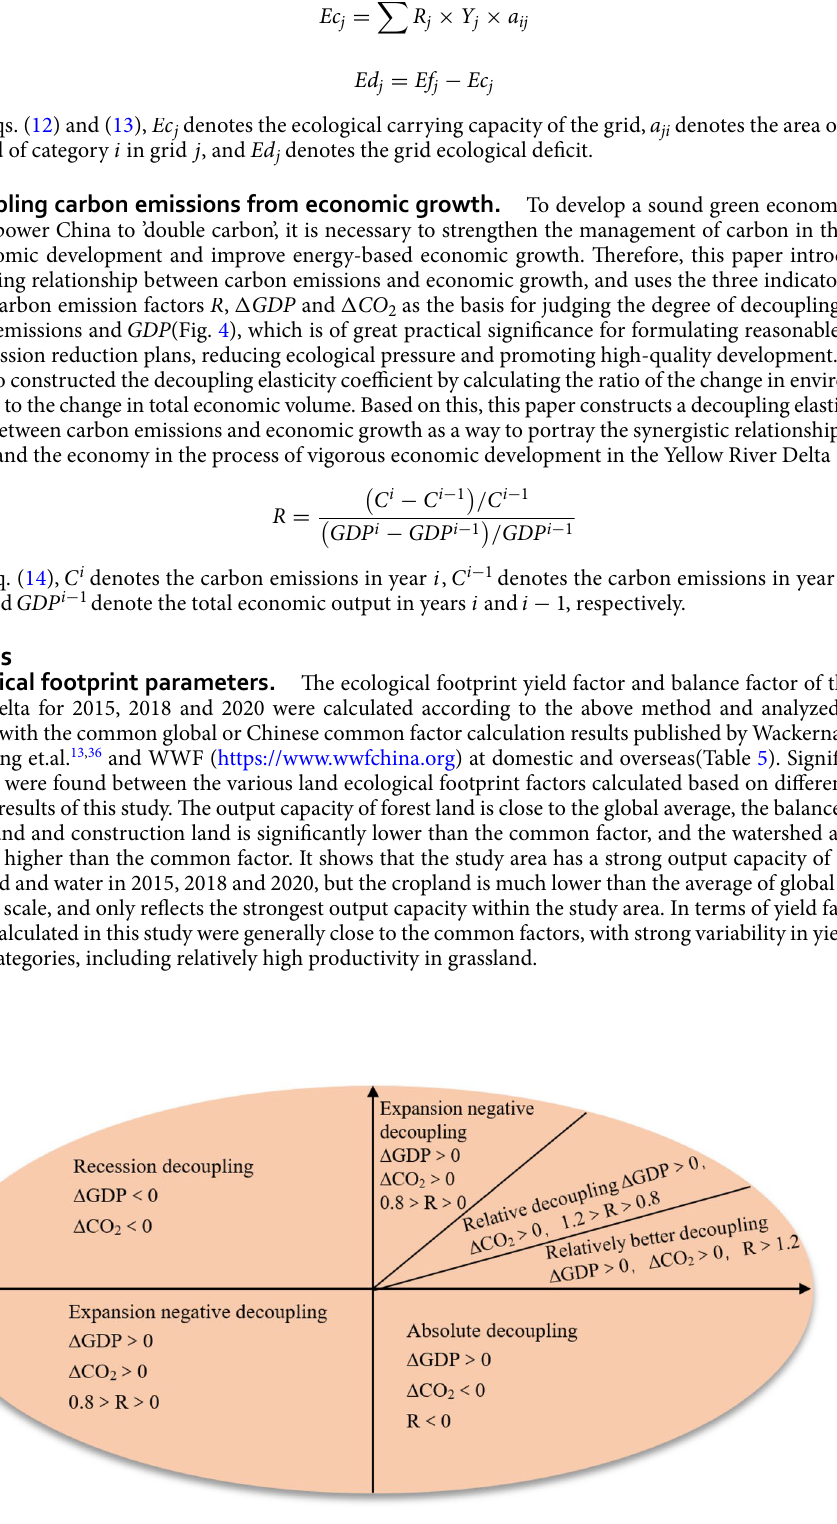
Figure 4. Types of decoupling of economic development and carbon